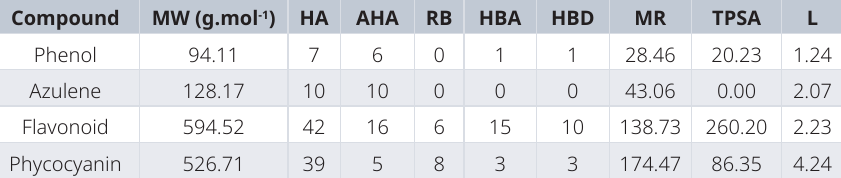
Table 2. Physicochemical parameters of the analysis compound predicted by Swiss ADME. Compound